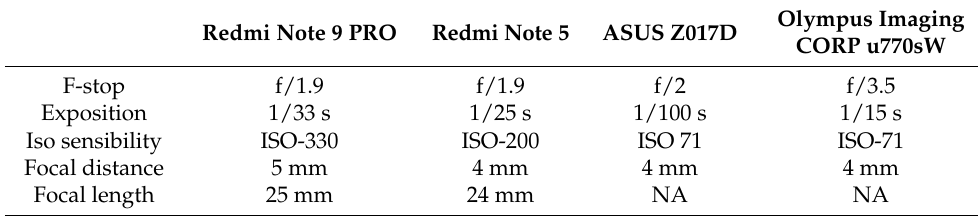
Table 2. Main specifics of the camera devices used for the acquisition of the photos. The PetWound database is composed of images acquired with 4 different camera devices. In detail, there are 3 different smartphone digital cameras and 1 Olympus digital